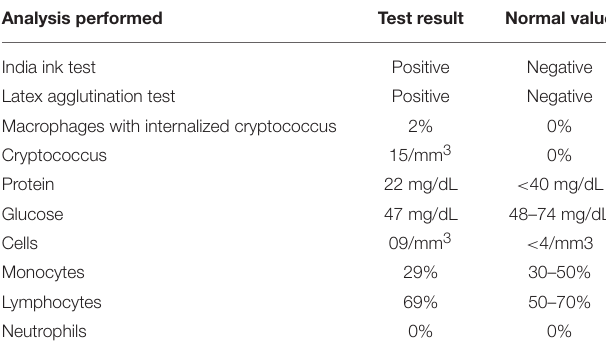
TABLE 1 | Laboratory examination of cerebrospinal